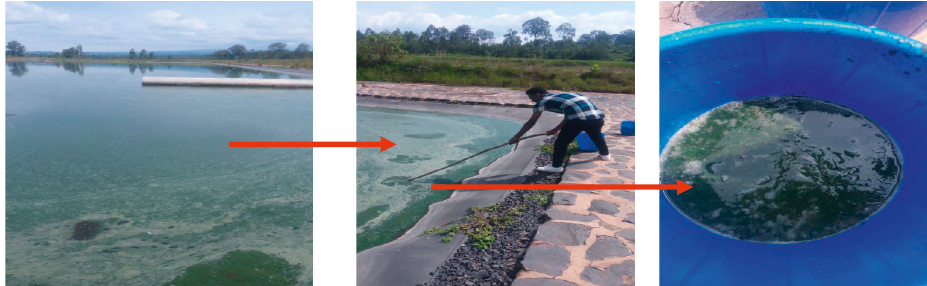
Figure 1: Oxidation pond of JiT from where microalgae were collected.